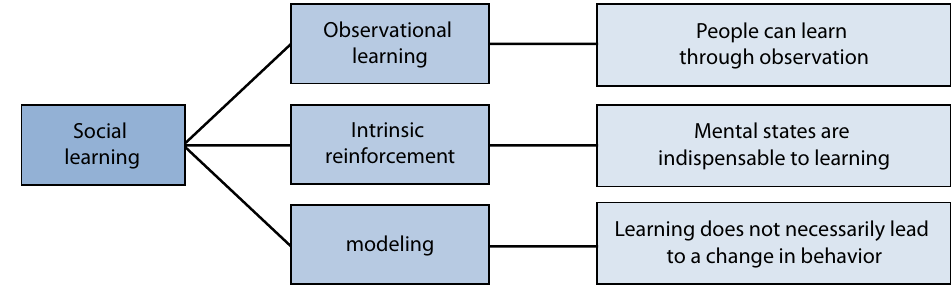
fig. 1. Modeling of social learning